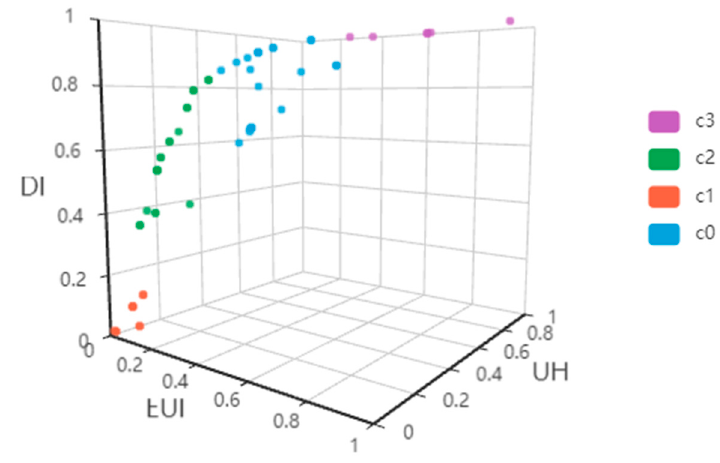
Figure 7. Illustration of the clustering distribution of non-dominated solutions.